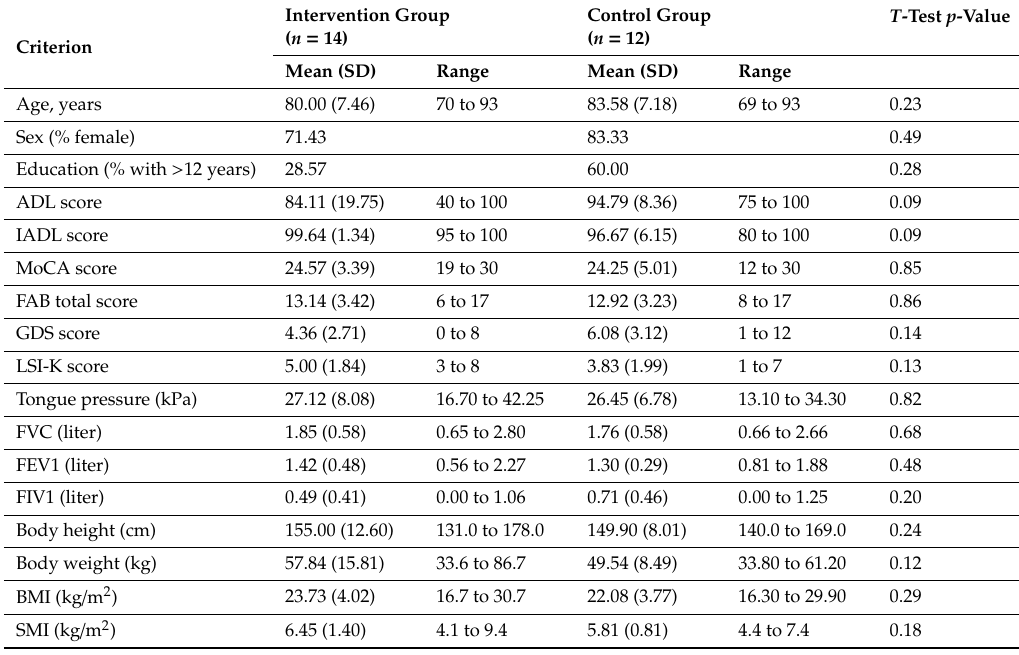
Table 1. Participant characteristics at